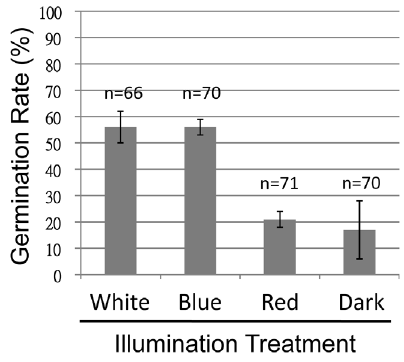
Figure 3. White and blue light enhances germination of Thalassiahemprichii seeds. Seeds were immersed in the reconstituted seawater and illuminated under different light treatments. The light intensities were set at 50 m mol/m 2 s. ‘‘n’’ indicates combined number of seeds in duplicated tests. The experiments were terminated when the germination rate of at least one group exceeded 50%. Error bars indicate 95% C.I.